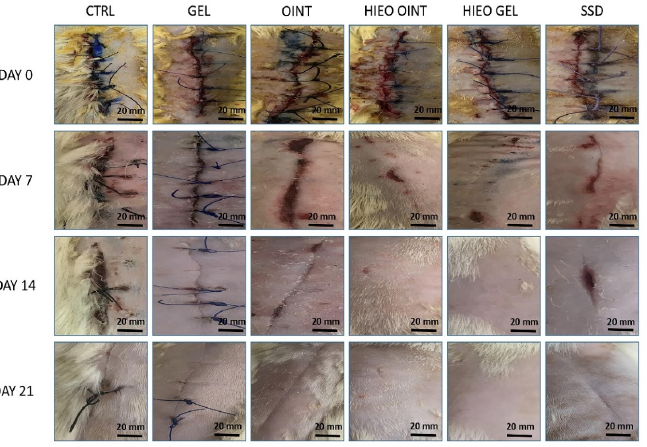
Figure 2. The wound healing effect of H. italicum essential oil ‐ based topical formulations on incision wound model on different days (0, 7, 14, 21).